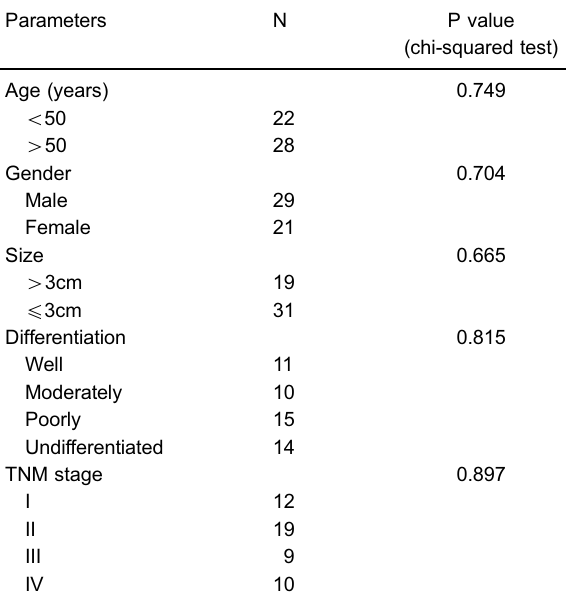
Table 1. Clinicopathological features of 50 patients with gastric